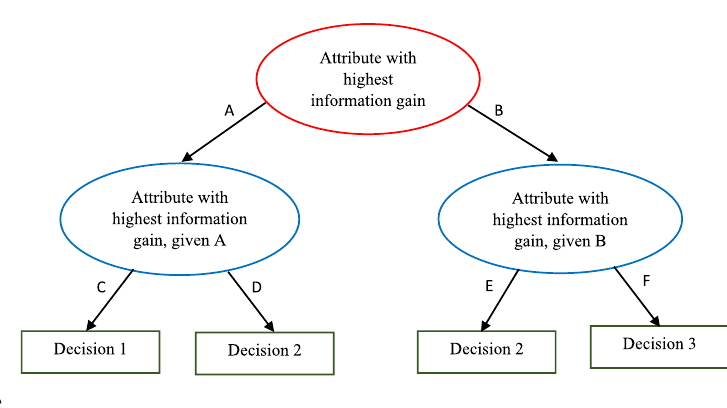
Fig. 5 J48 decision tree